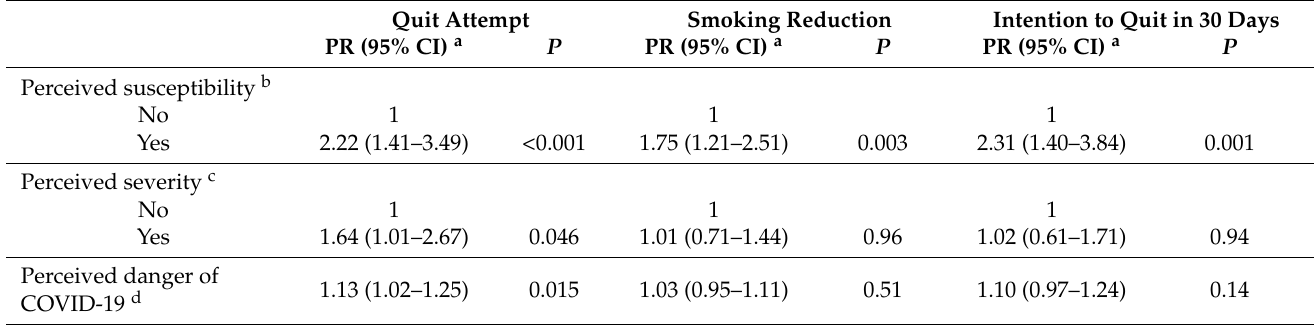
Table 3. Association of perceptions of smoking and COVID-19 with quitting-related